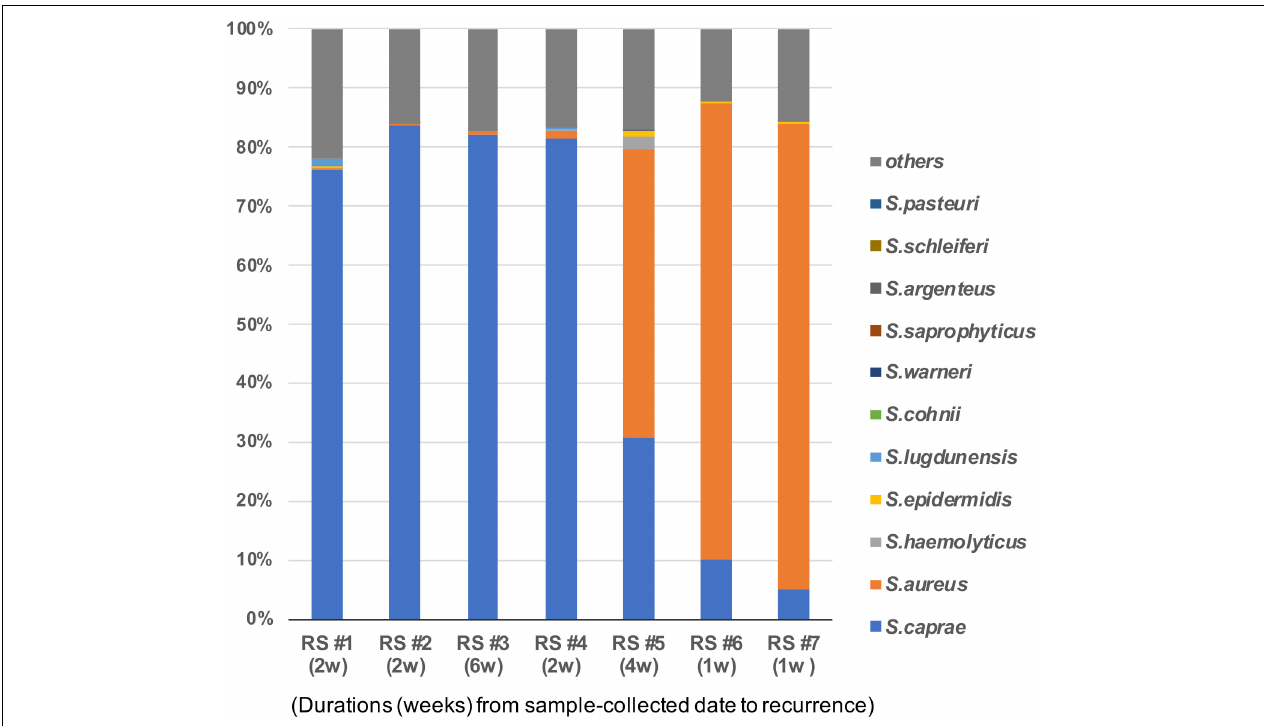
FIGURE 3 | Staphylococcus caprae and S. aureus on healed skin of the seven patients who suffered from RPI within 1–6 weeks. Bacterial composition of the seven sites. Duration from the sample collection date to RPI is described in parentheses. The correlation of the abundance of S. aureus and S. caprae is shown in Supplementary Figure 4 .